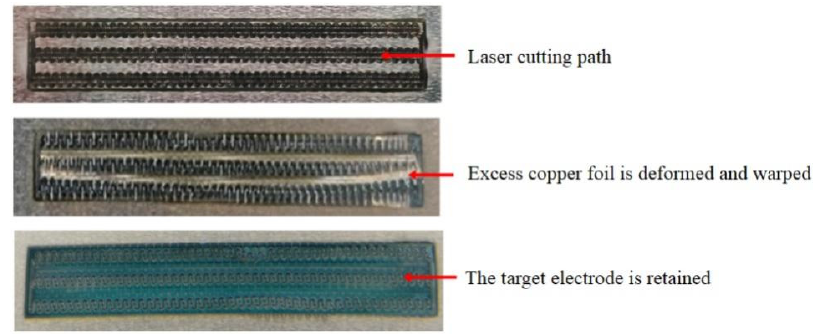
Figure 8. Laser assisted manual stripping process.